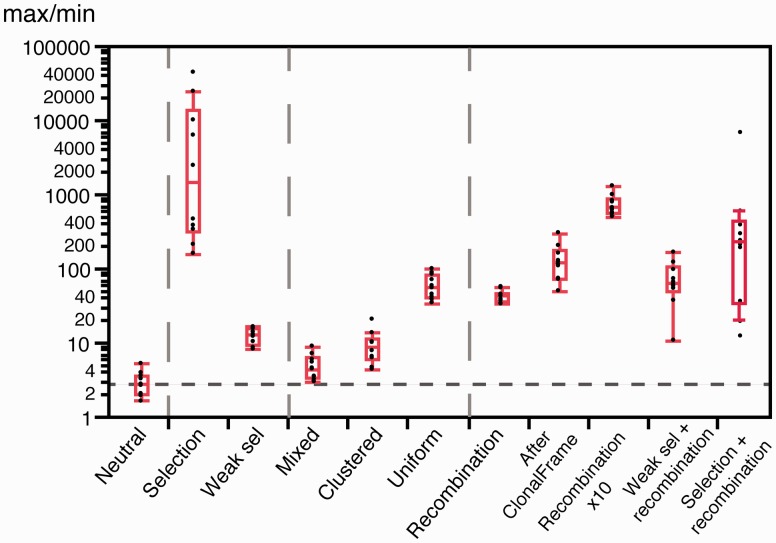
Boxplots of the ratios between the maximal and minimal Ne.u values for skyline plots (ten simulations each), across the different types of simulations. All other categories were significantly different from Neutral (all P < 0.01 Wilcoxon tests, except the comparison between Neutral and Mixed, P = 0.0102, same test).